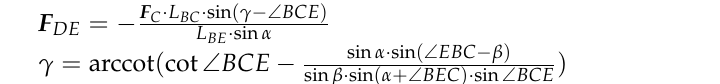
Figure 4. Schematic of cylinder #4 and its linkage mechanism. For cylinder #6 as shown in Figure 5, the resultant external force applied on cylinder #6 F DB can be expressed as